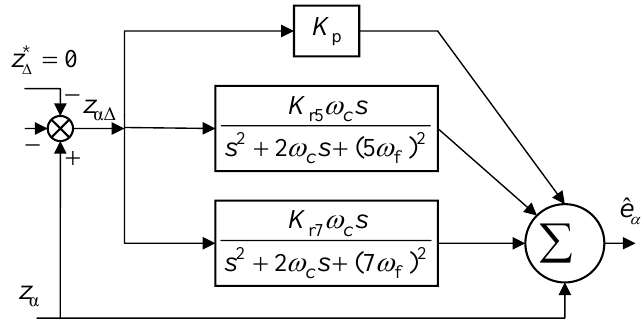
Figure 4. Parallel module composed of multiple PR controllers. Firstly, multiple PR controllers were designed in parallel to extract the negative se- quence components of the 5th and 7th harmonics in the back EMF, and then the extracted components were compensated into the back EMF, which achieved the effect of suppressing harmonics. The closed-loop structure is shown in Figure 5.